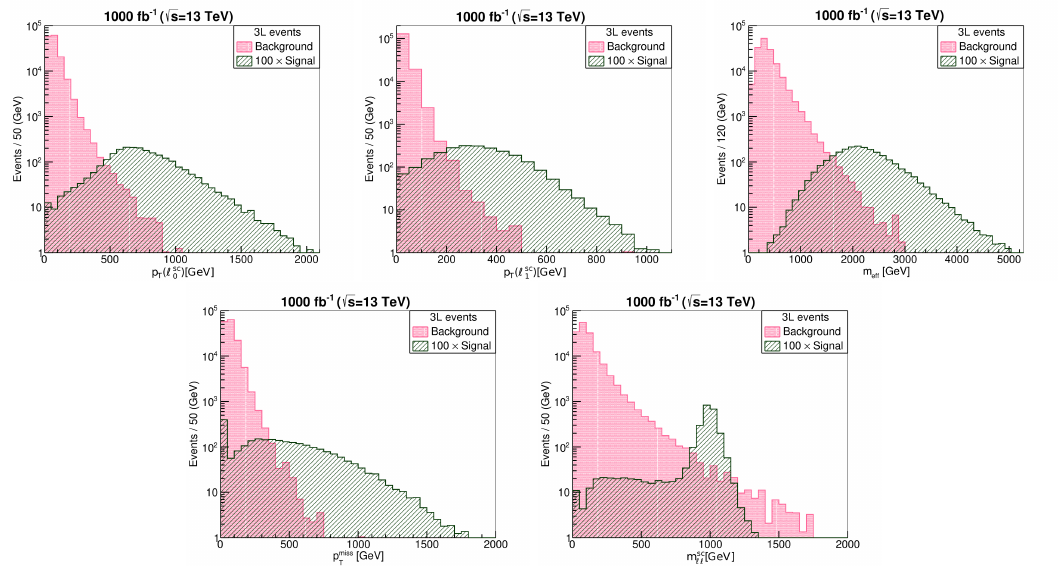
Figure 5 . Kinematic distributions for 3L events for BP1 . Top panel: the p T -distributions of the leading (leftmost) and subleading (middle) same-charge lepton, and the m eff distribution (right- most). Bottom panel: the p miss (left) and the m sc (right) distributions. The events are weighted at T ‘‘ 1000 fb − 1 luminosity at the 13 TeV